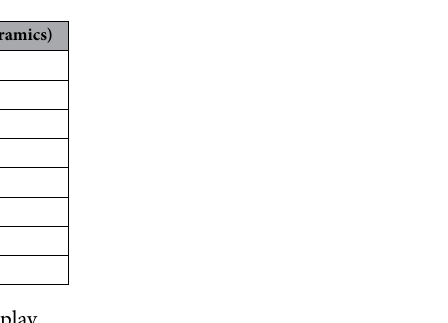
Table 1. Information of comparison wells in the Ma-131 play.